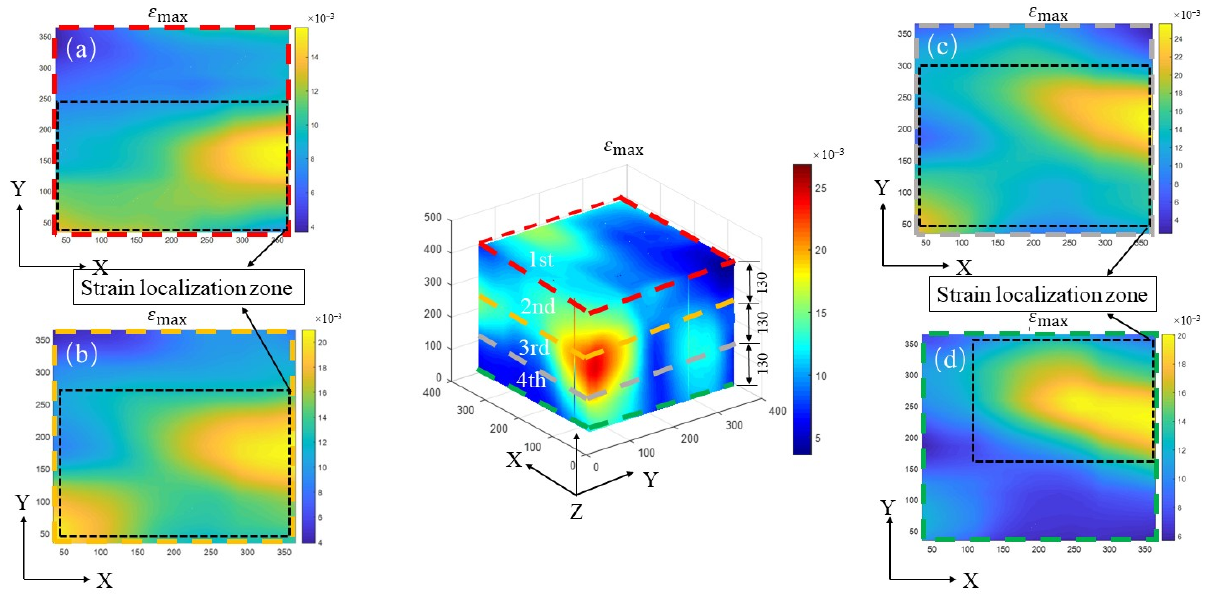
Figure 14. Principal strain map of di ff erent sections under 50 MPa. ( a ) the fi rst section; ( b ) the sec- ond section; ( c ) the third section; ( d ) the fourth section. section; ( c ) the third section; ( d ) the fourth